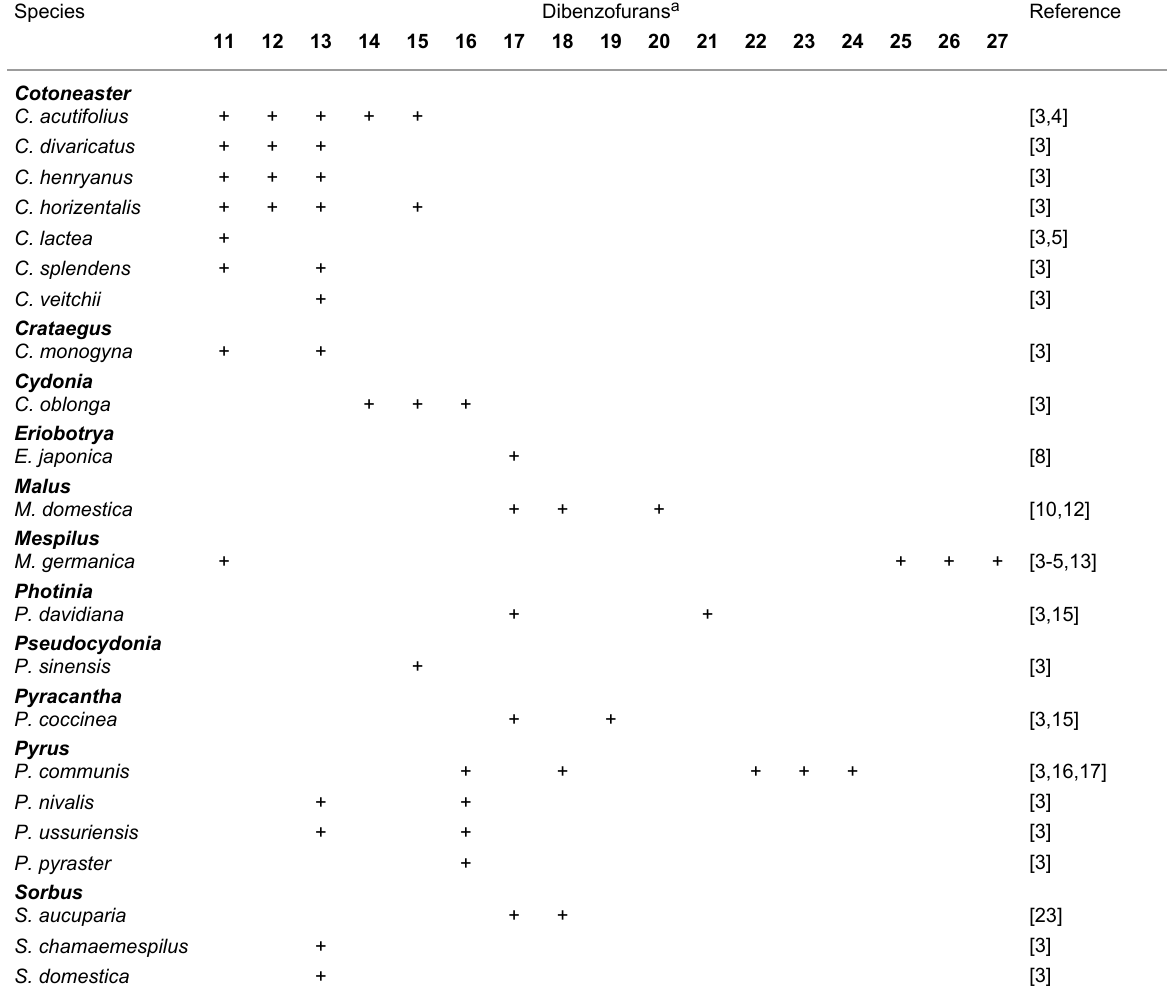
Table 2: Occurrence of dibenzofuran phytoalexins in species of the Pyrinae.